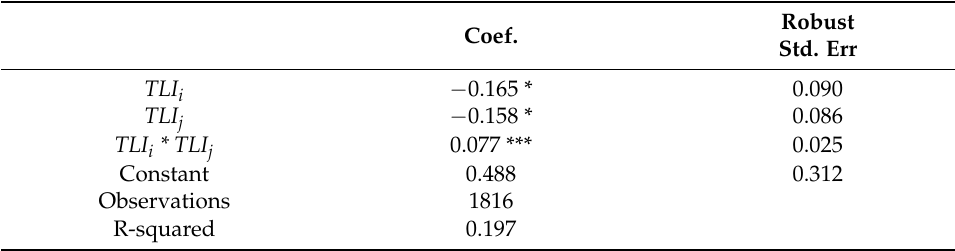
Table 11. Results of Equation